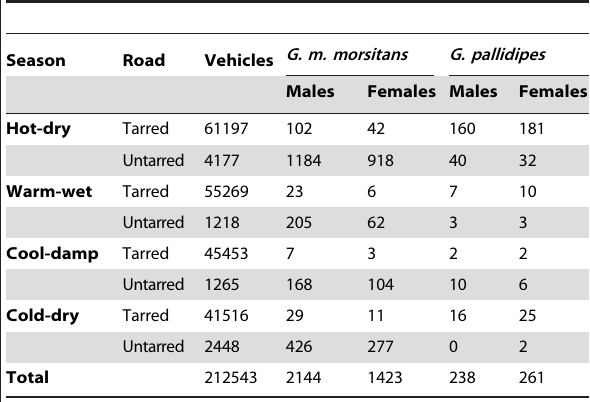
Table 6. Catches of tsetse from vehicles leaving the Zambezi Valley of Zimbabwe at various seasons.